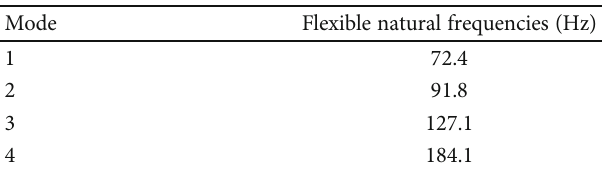
Table 2: First four fl exible vibration natural frequencies of meniscus